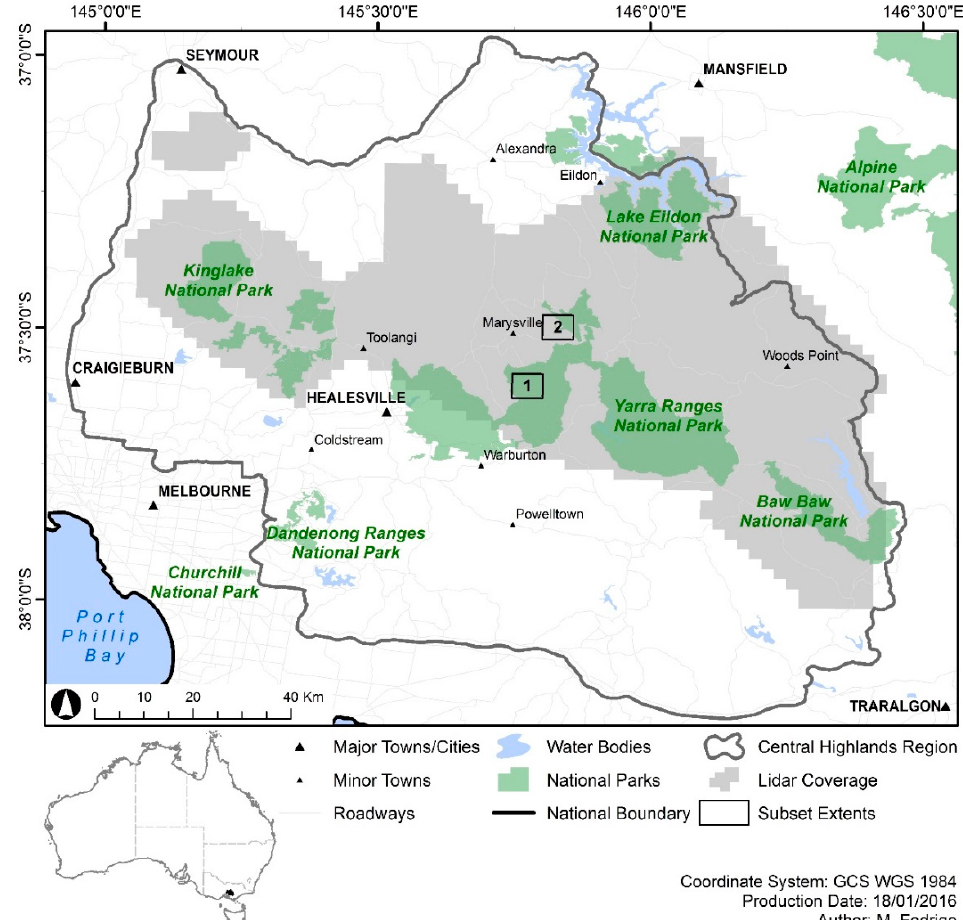
Figure 1. Map of the Central Highlands region and airborne lidar coverage in south-eastern Australia. Extent 1 and 2 (labelled subsets) contain stand types of importance to the study across a broad elevational range.